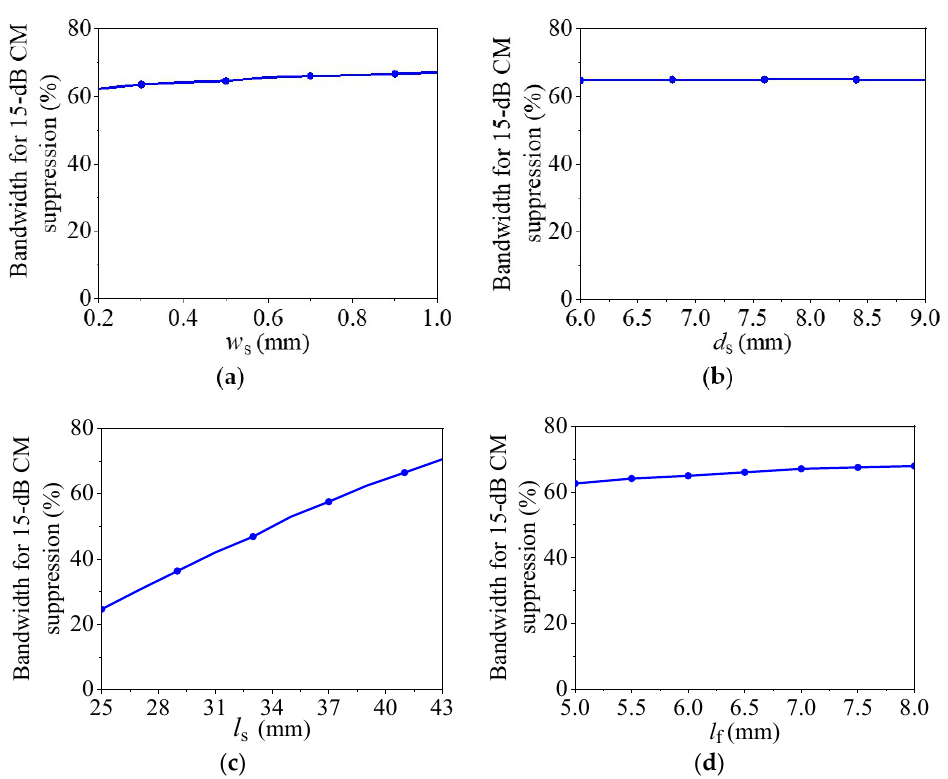
Figure 9. The simulated bandwidth for 15-dB CM suppression of the proposed balanced SIW phase shifter with different w s , d s , l s , and l f . ( a ) With different w s . ( b ) With different d s . ( c ) With different l s . ( d ) With different l f .